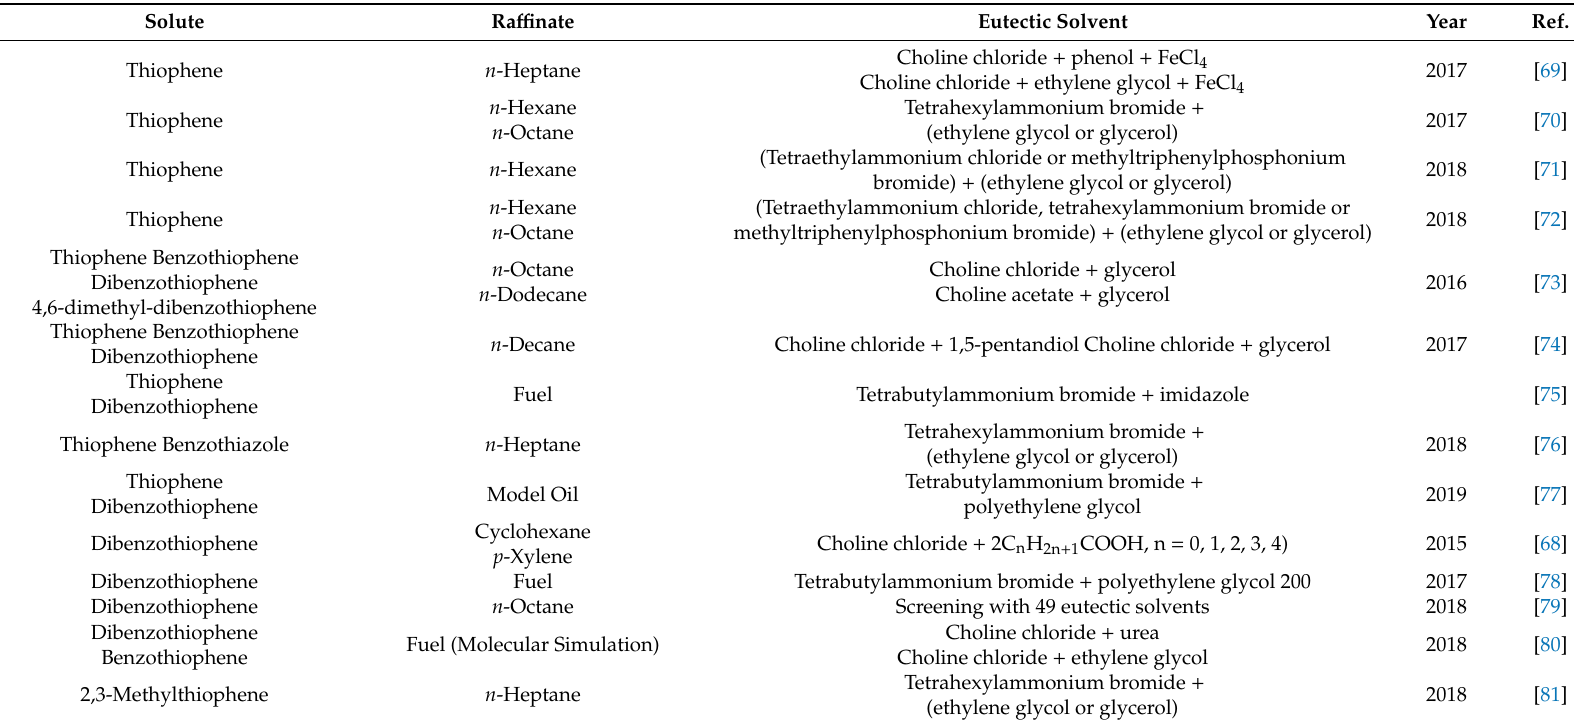
Table 3. Eutectic Solvents in the Extraction of Sulfur-Containing Aromatic